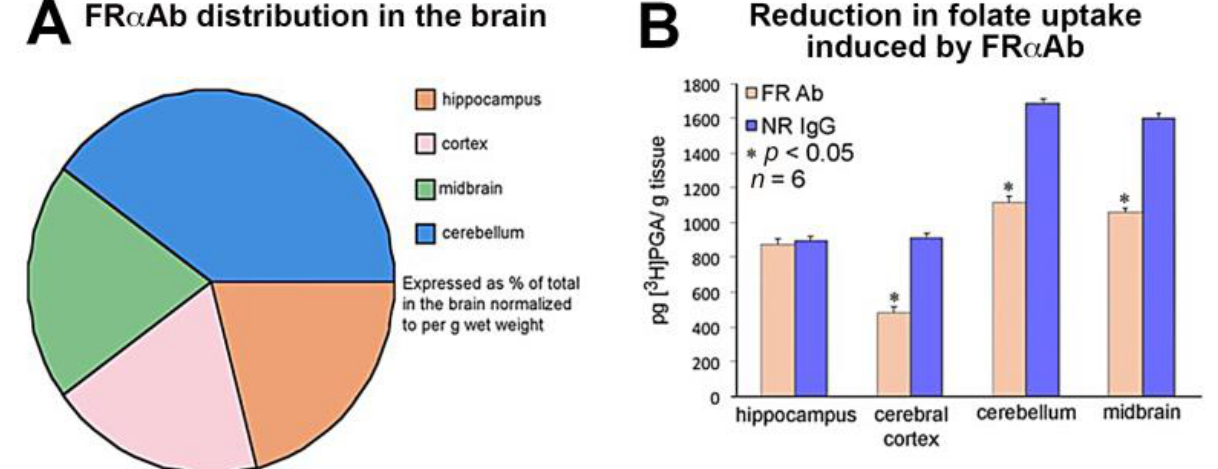
Figure 1. Anti-folate receptor antibody distribution and its effect on folate uptake in PND13 rat brain. ( A ). Antibody distribution in the cortex, midbrain, and hippocampus and in the cerebellum (total recovered was 1080 pg IgG antibody/g of whole brain tissue). The pie chart shows % distri- bution per gram of tissue ( n = 4); ( B ). Uptake of 3 H-PGA in these rats showed a 30–40% decrease in uptake in the cortex, midbrain, and cerebellum ( n = 6 for both FR α Ab and NR IgG groups). Asterisk (*) represents one-way ANOVA statistical significance between FR Ab and NRIgG across each brain region ( p <0.05).